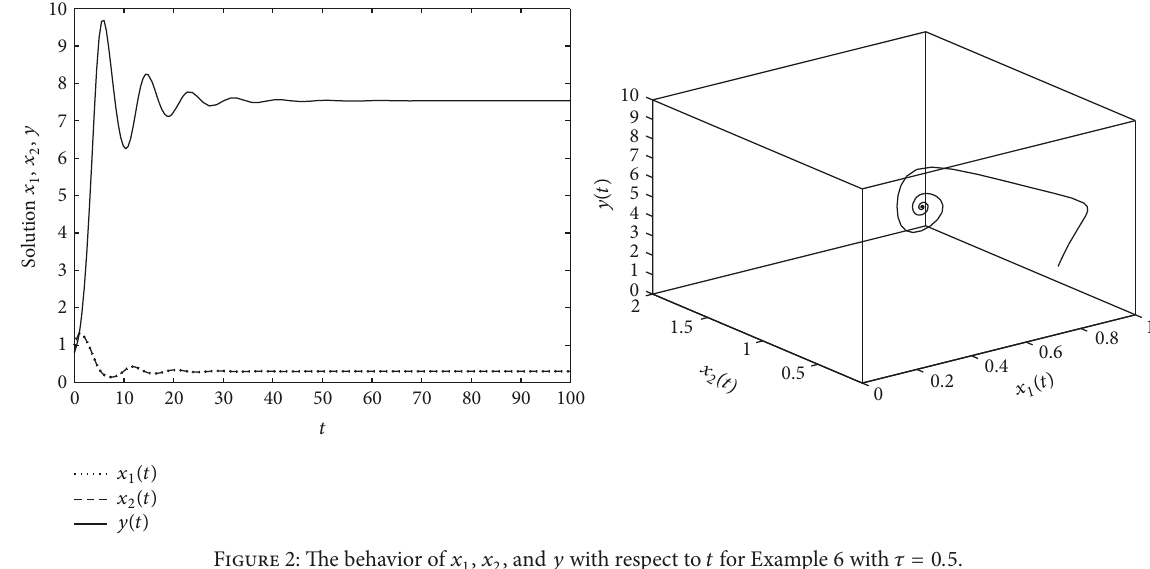
Figure 2: The behavior of 𝑥 1 , 𝑥 2 , and 𝑦 with respect to 𝑡 for Example 6 with 𝜏 = 0.5 .